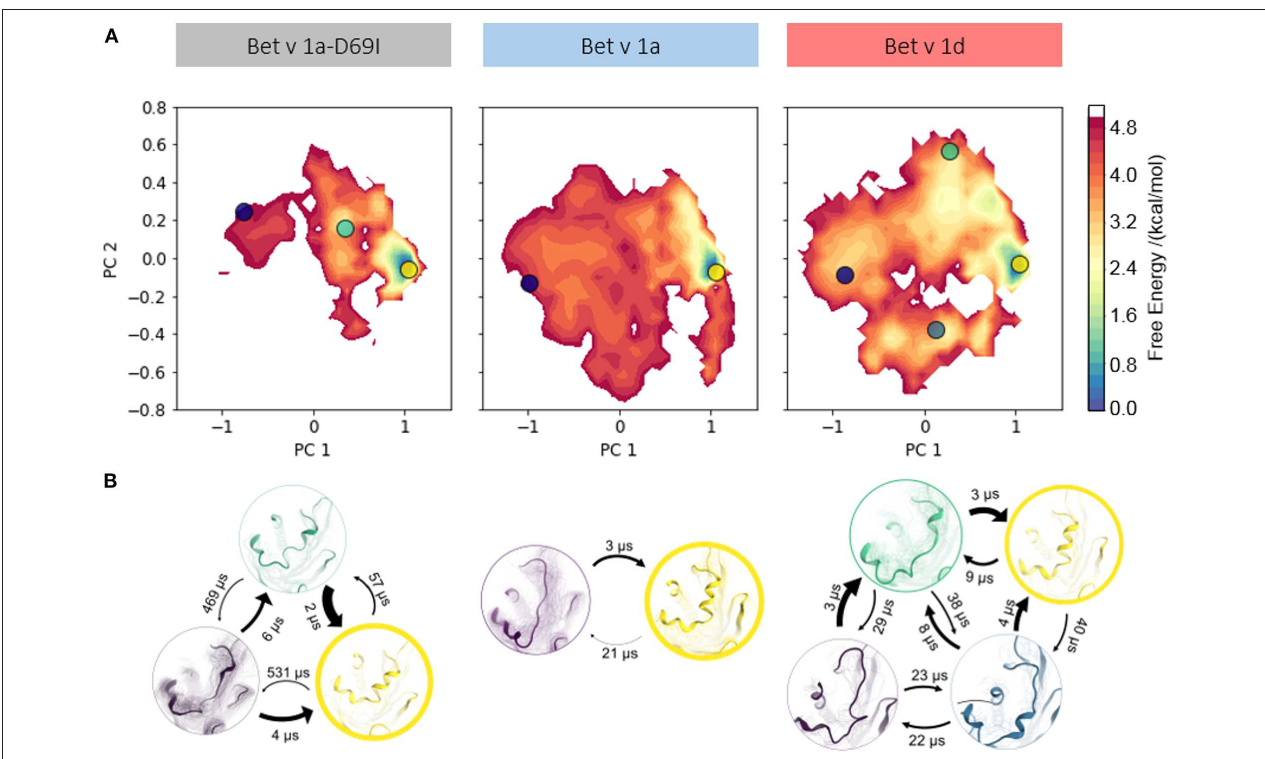
FIGURE 3 | (A) Free energy landscape during local unfolding. The accumulated structural information from the seeded cMD simulations were color-coded according to the reweighted free energies and projected onto the first two eigenvectors of the combined PCA space. (B) We constructed an MSM of the partial unfolding process of each variant. Estimating the state populations of the stabilized variant Bet v 1a-D69I , the wild-type protein Bet v 1a and the destabilized variant Bet v 1d , we found 95 ± 2, 87 ± 3, and 65 ± 6% of the ensembles in the folded state,